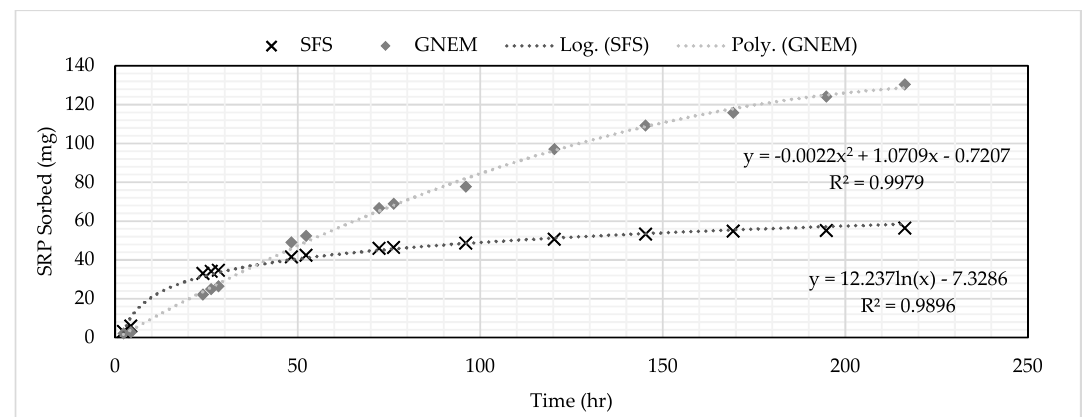
Figure 5. Comparison of SRP loading onto the GNEM and SFS media.